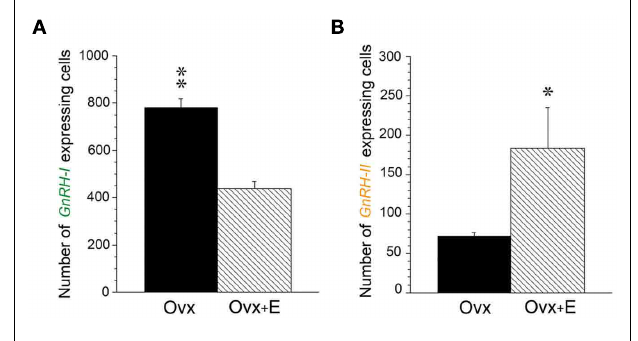
FIGURE 4 | Differential regulation of GnRH-I and GnRH-II gene expression by estradiol in ovariectomized rhesus macaques. (A) Histogram depicting number of cells expressing GnRH-I mRNA in the hypothalamus of ovariectomized (OVX) and ovariectomized/estradiol-treated (OVX + E) animals, as revealed by semi-quantitative in situ hybridization histochemistry.The number of detectable GnRH-I cells in the hypothalamus was markedly lower in the OVX + E animals than in the OVX animals. (B) Histogram depicting number of cells expressing GnRH-II mRNA in the MBH of OVX and OVX + E animals, as revealed by in situ hybridization.The number of detectable GnRH-II cells in the MBH was significantly greater in the OVX + E animals than in the OVX animals.The in situ hybridization was performed on a series of six coronal hypothalamic sections from each animal ( N = 3/group); the sections were collected at ∼ 200- μ m intervals. ** P < 0.01, * P < 0.05. (Adapted from Densmore and Urbanski, 2004, with permission from the Society for Endocrinology).